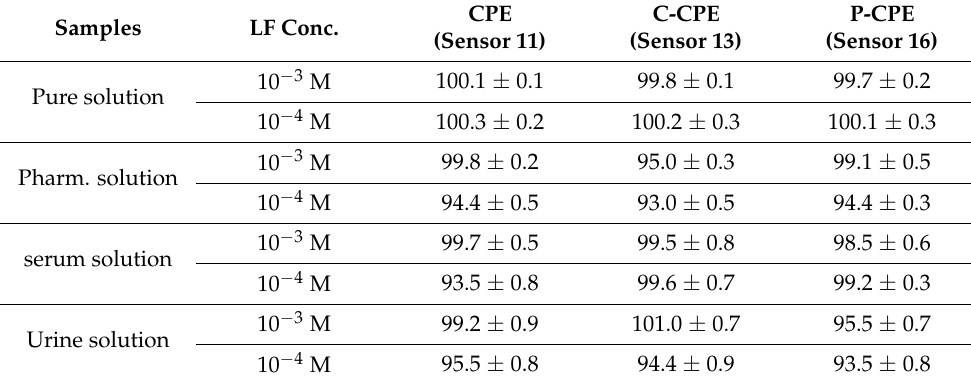
Table 5. Recovery values of the best sensors for the determination of LF using a direct potentiometric method at room temperature of 22 ± 2 ◦ C at pH 2.2. The electrode compositions (%, wt / wt ) are given in (Table 1).